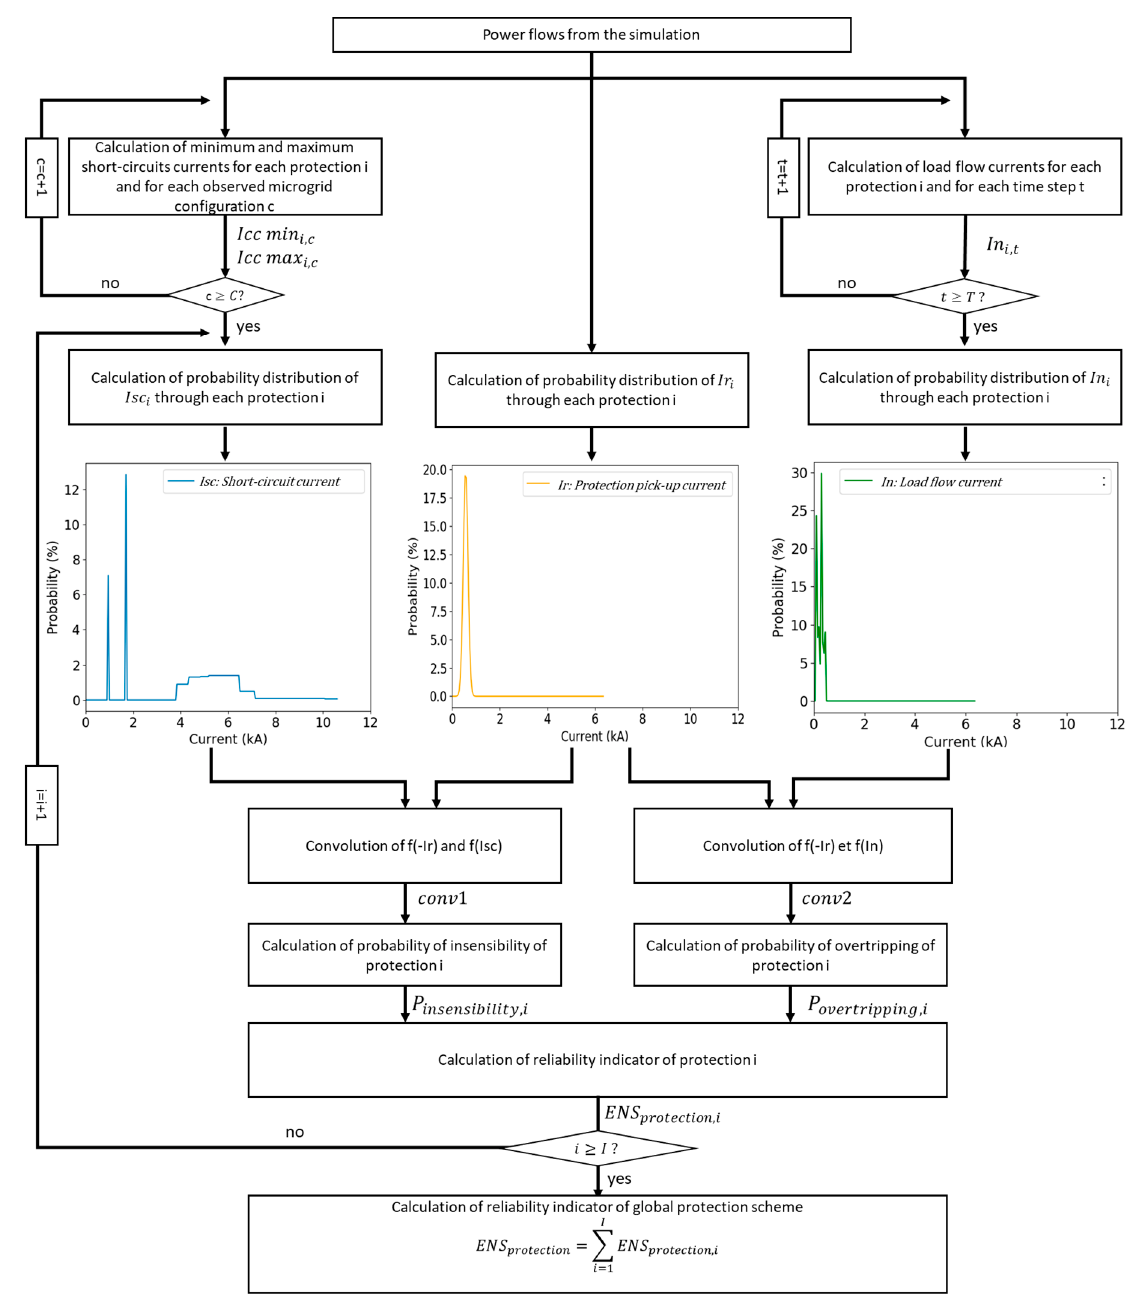
Figure 4. Overview of the method developed to assess protection reliability.